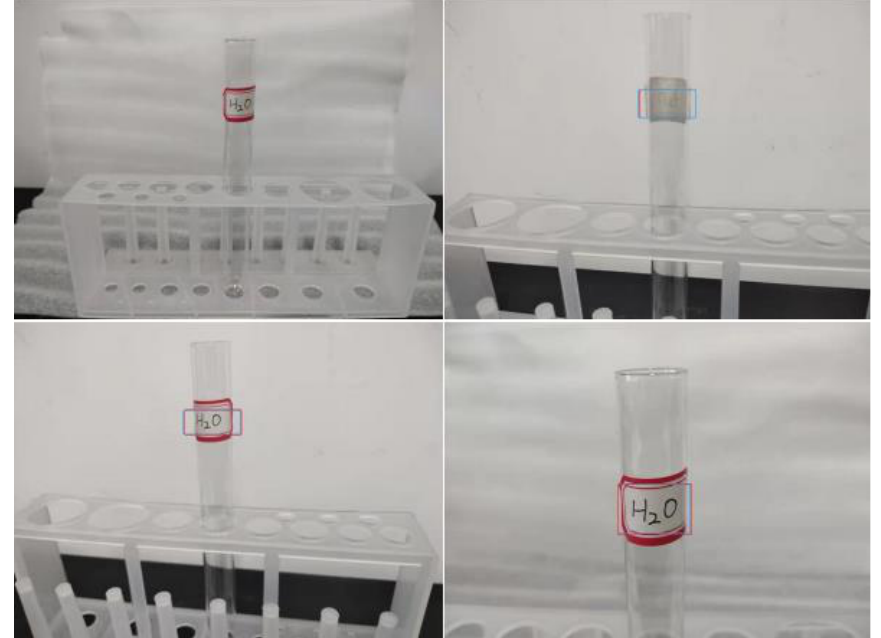
Figure 17. Label location scraping experiment.